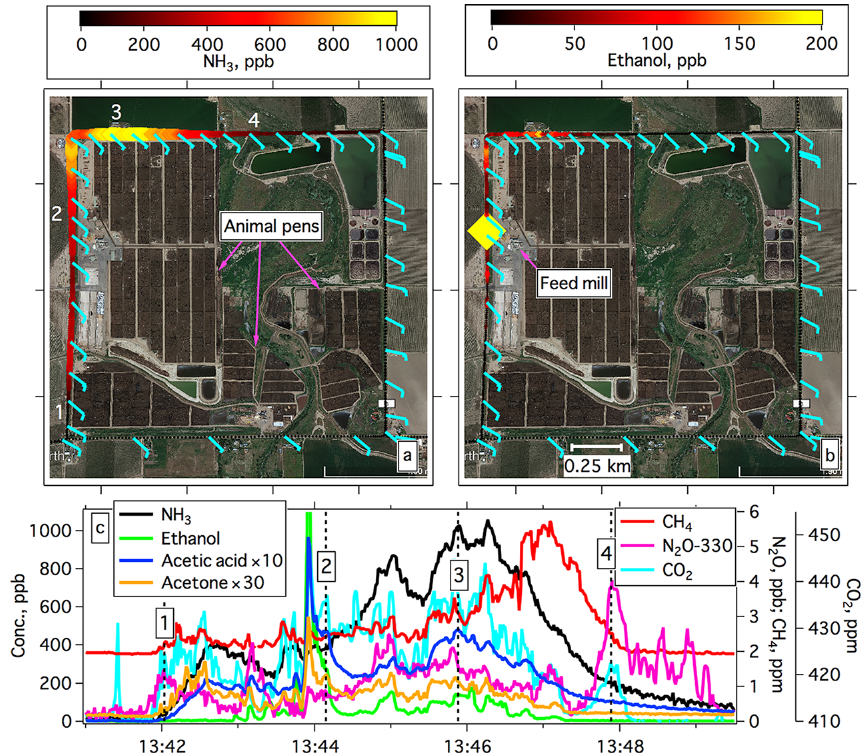
Figure 1. (a, b) Drive track of mobile laboratory color- and size-coded by NH 3 (a) and ethanol (b) concentrations around a beef feed yard (beef no. 1). The prevailing wind is shown by wind barbs (light blue flags) in the map. (c) Time series of NH 3 , CH 4 , CO 2 , N 2 O, ethanol, acetic acid and acetone measured downwind of the beef feed yard. Numbers (1–4) in panels (a) and (c) are used to allow for alignment of the mobile laboratory locations on the map with the corresponding time series in panel (c)